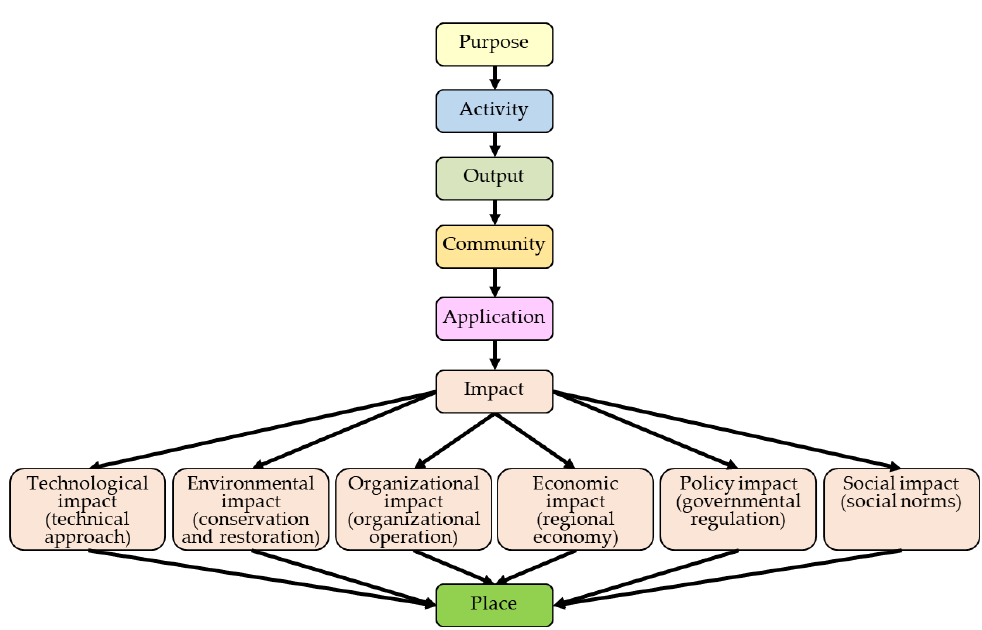
Figure 1. A common framework of program monitoring and evaluation.